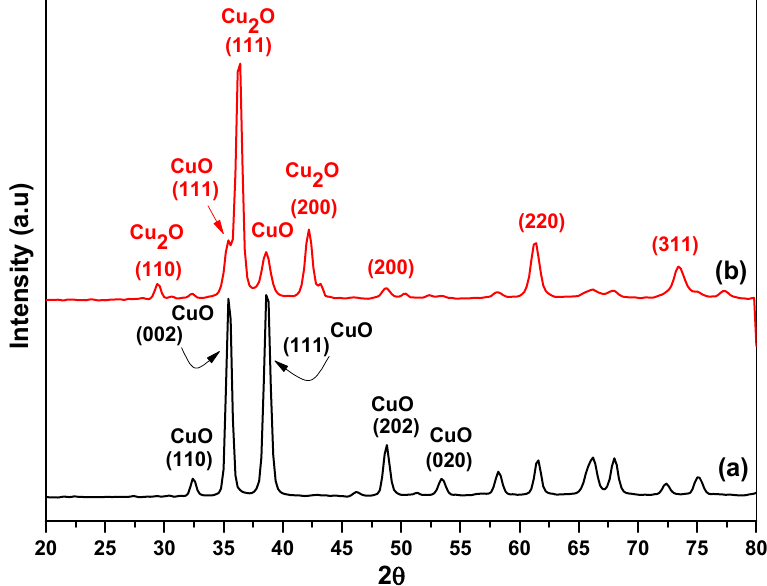
Figure 1. X-ray diffraction patterns of ( a ) bulk fabricated CuO and ( b ) pomegranate seeds extract (PSE)-capped Cu 2 O/CuO materials fabricated by the aqueous solution combustion approach.